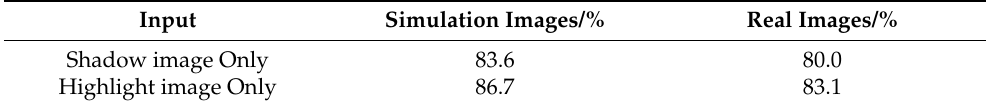
Table 6. Classification accuracy of test